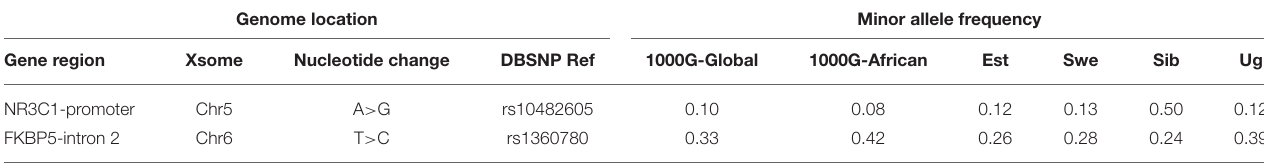
TABLE 2 | Genome location and minor allele frequency of the rs10482605 and rs1360780 single nucleotide polymorphisms among different populations.